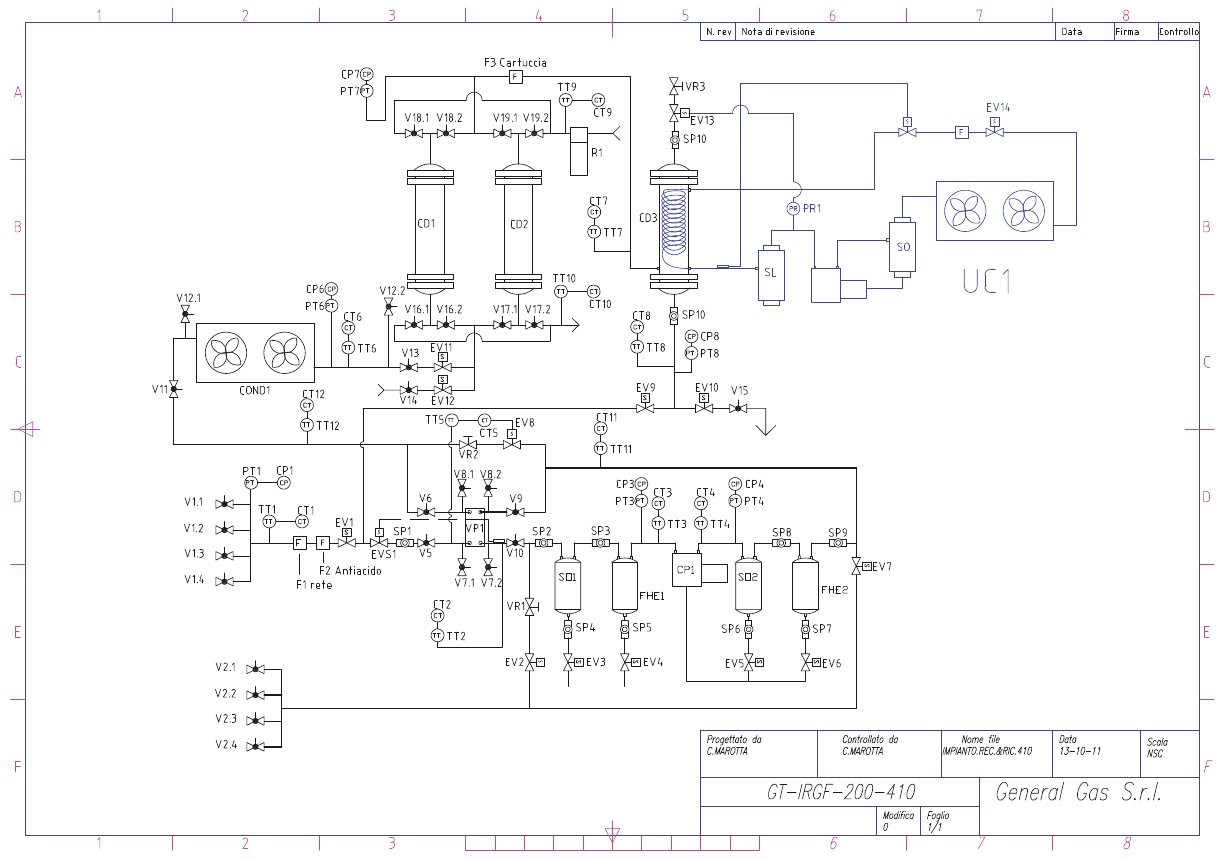
Figure 2: Experimental plant for refrigerant gas